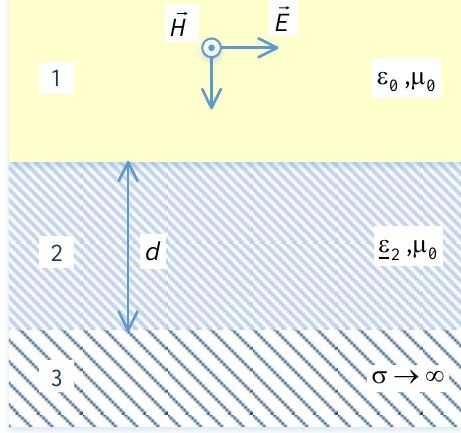
Figure 13. Idealized theoretical model of CrossPMA.